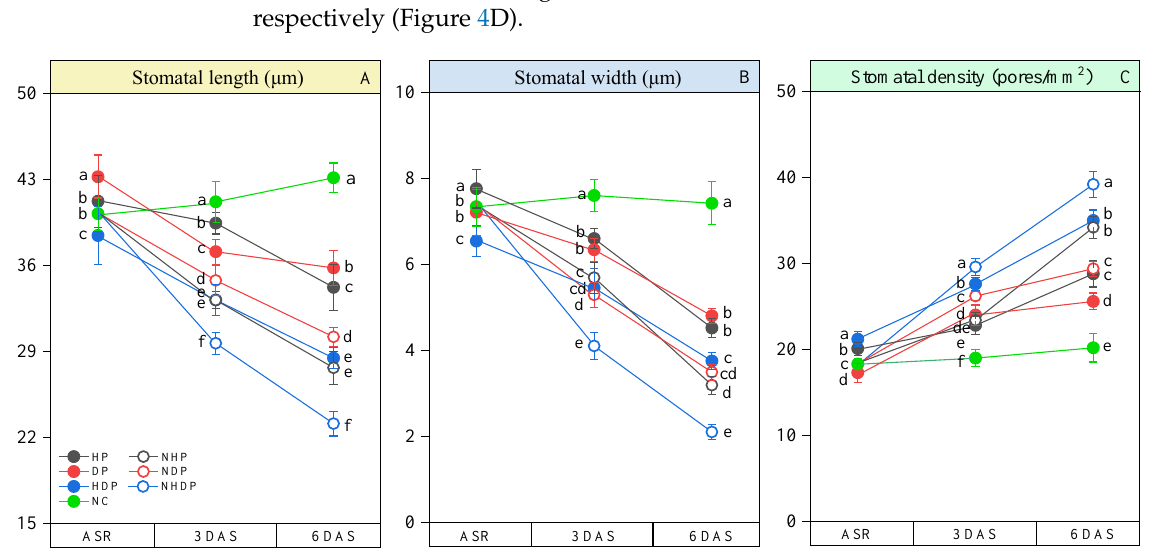
Figure 3. Effects of stress priming on the stomatal length ( A ), stomatal width ( B ), and stomatal density ( C ) of seedlings under stress conditions. HP, heat priming + later heat stress; DP, drought priming + later drought stress; HDP, combined stress priming + later combined stress; NHP, no heat priming + later heat stress; NDP, no drought priming + later drought stress; NHDP, no combined stress priming + later combined stress; NC, no stress priming + no later stress. Data are means ± SD (n = 15), where different letters designate significant differences at the 0.05 level.